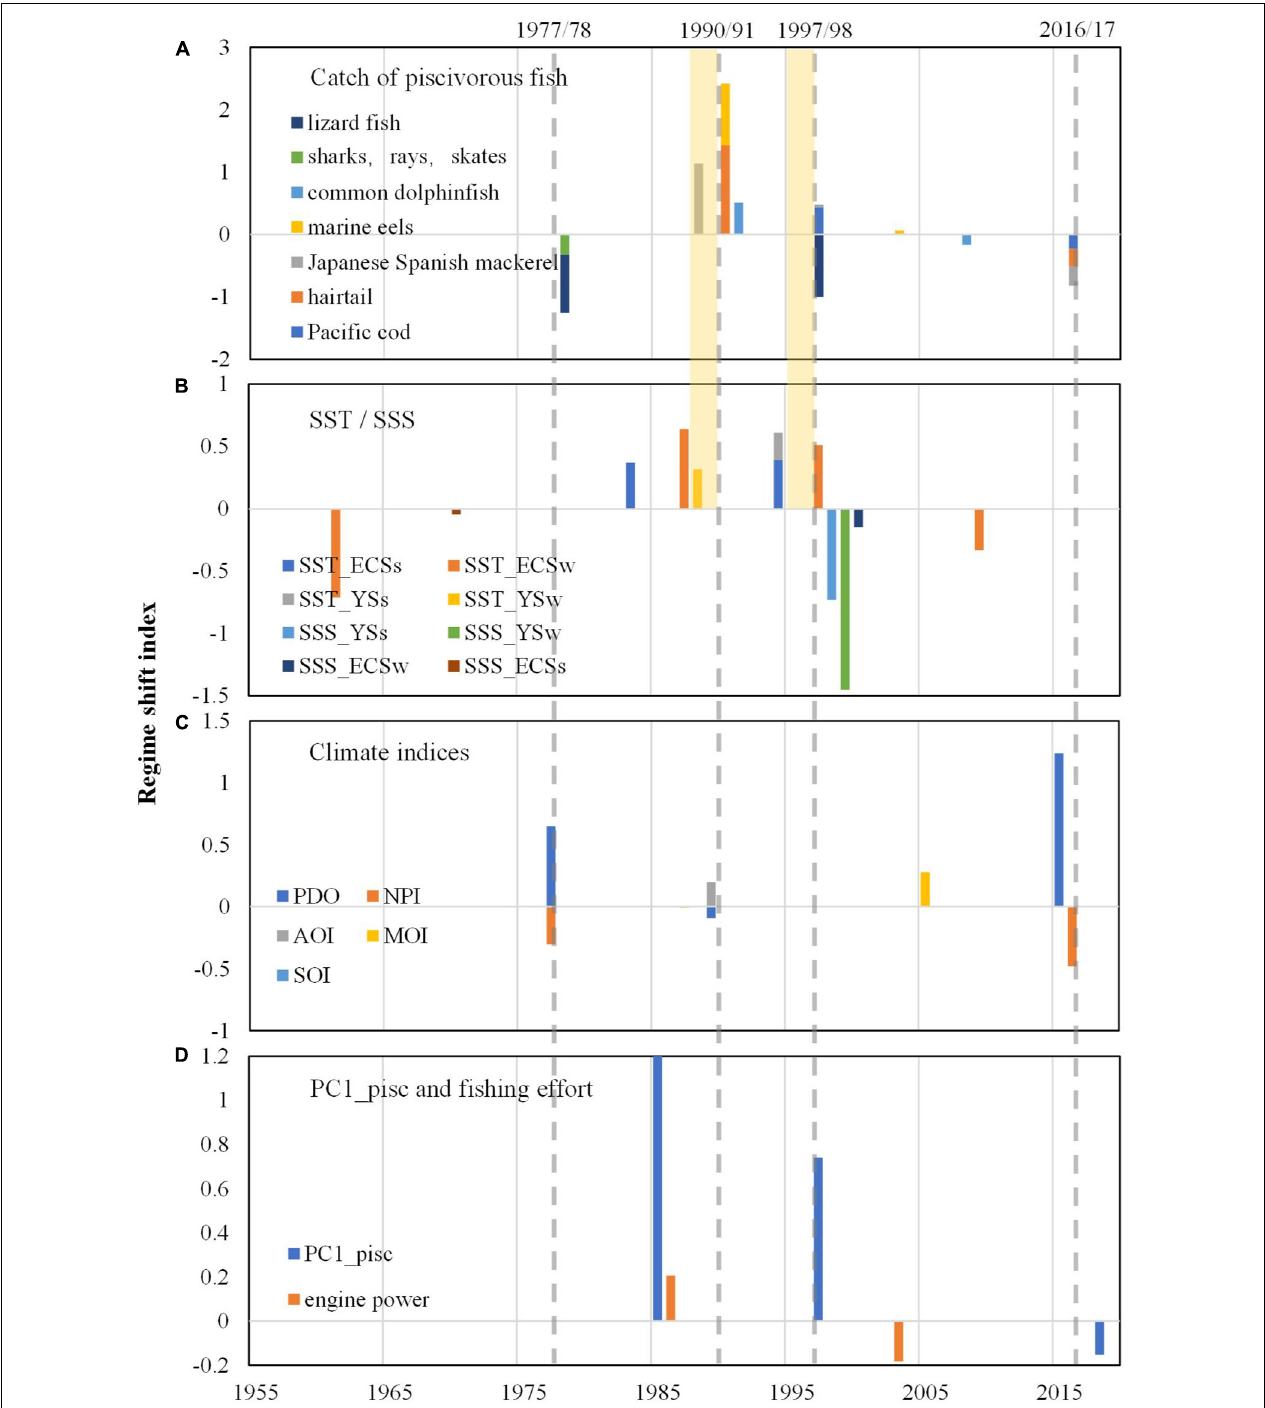
FIGURE 7 | Regime shift indices calculated by STARS: (A) for catch of piscivorous fishes; (B) for PC1 of SST (sea surface temperature) and SSS (sea surface salinity) indices; (C) for climatic indices. Pink dotted bars show gaps between catch and SST (e.g., winter and summer SSTs for the ECS are abbreviated as SST_ECSw and SST_ECSs, and so on) were the most important predictors with the highest mean importance, followed by SSS_YSw, SSS_YSs, SST_YSw and SST_YS.); (D) for PC1 of piscivorous catch and Chinese total marine fishing engine power (10 5 kw). Note that step changes during the period of 2016–2019 for piscivorous catch, PC1 of piscivorous catch and climate indices should be treated with cautions since they are at the end of time series and would need to be verified with additional data.